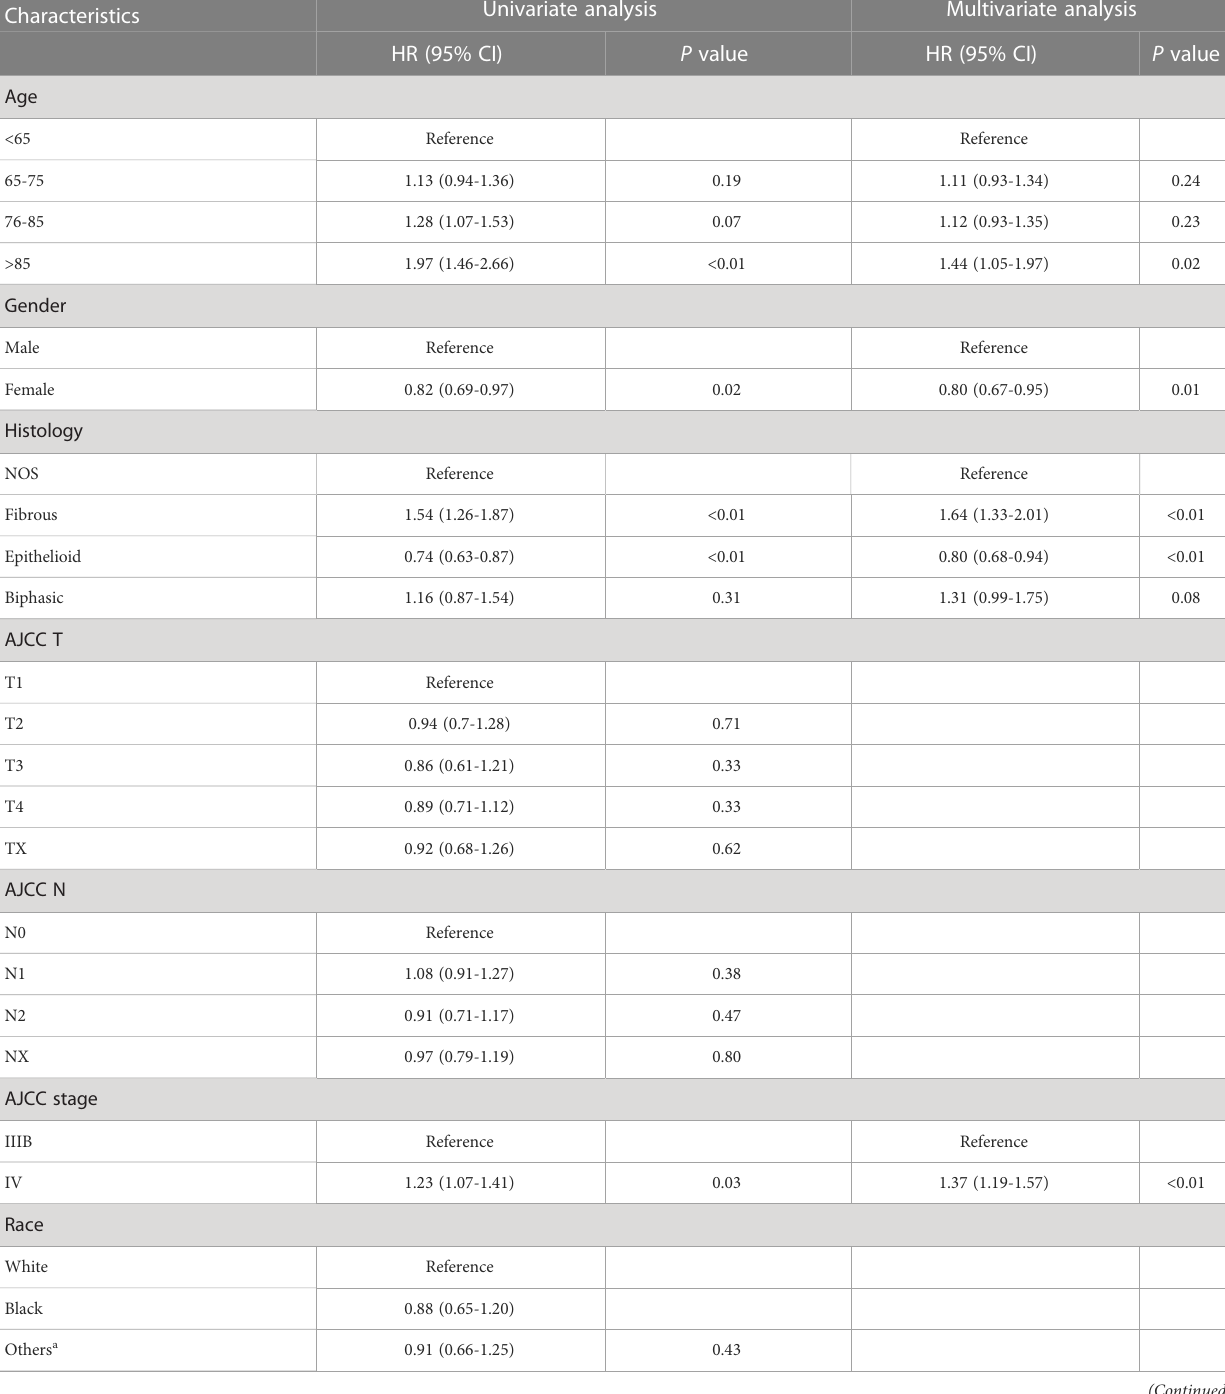
TABLE 2 Selection of variables independently associated with OS by univariate and multivariate Cox proportional hazards analysis in the training cohort.